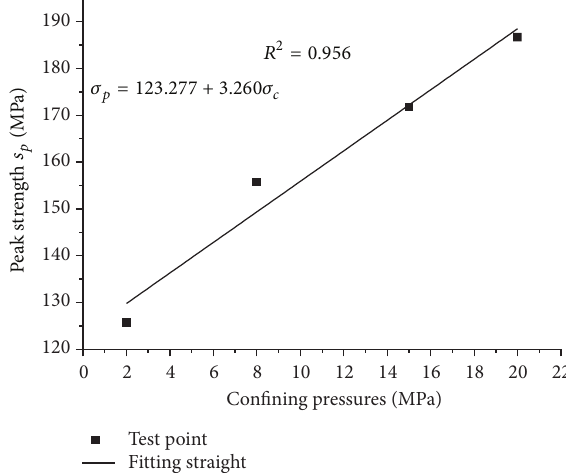
Figure 13: The variation of cohesion and internal friction angle with sphericity.